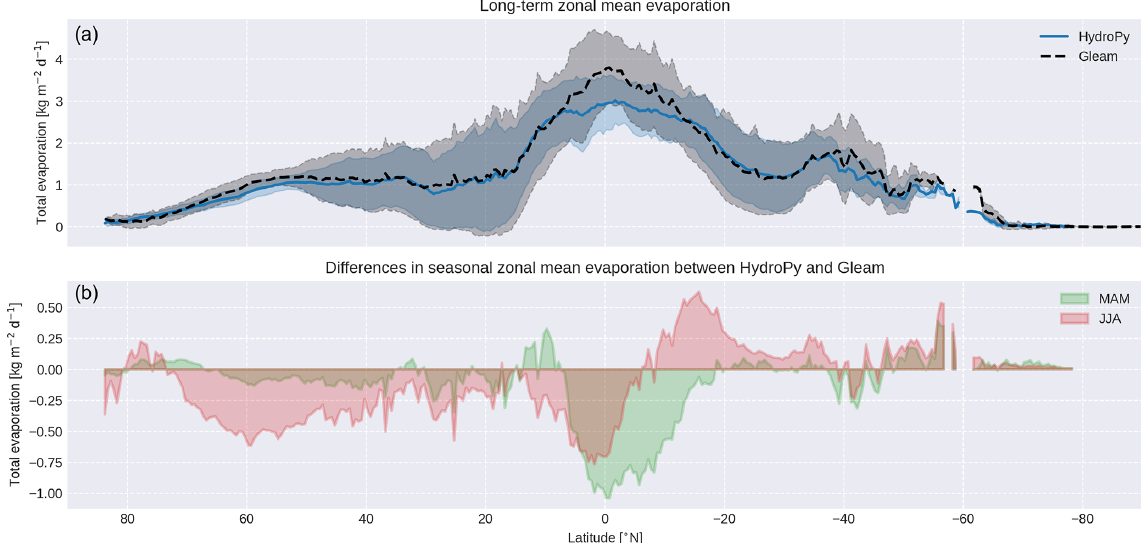
Figure 6. Zonal mean evaporation averaged over the period 1980–2014 for HydroPy and GLEAM (a) as well as their seasonal differences in the boreal spring (MAM) and summer (JJA) (b) .